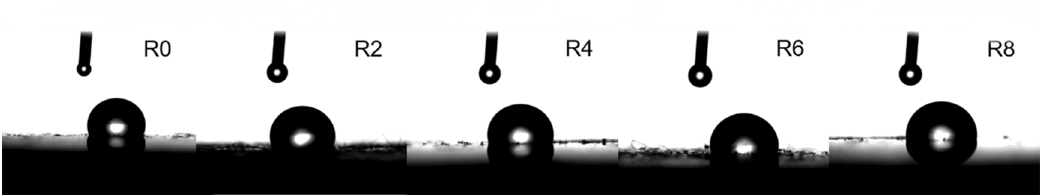
Figure 7 . Water contact angle images of vulcanizates. Figure 7. Water contact angle images of